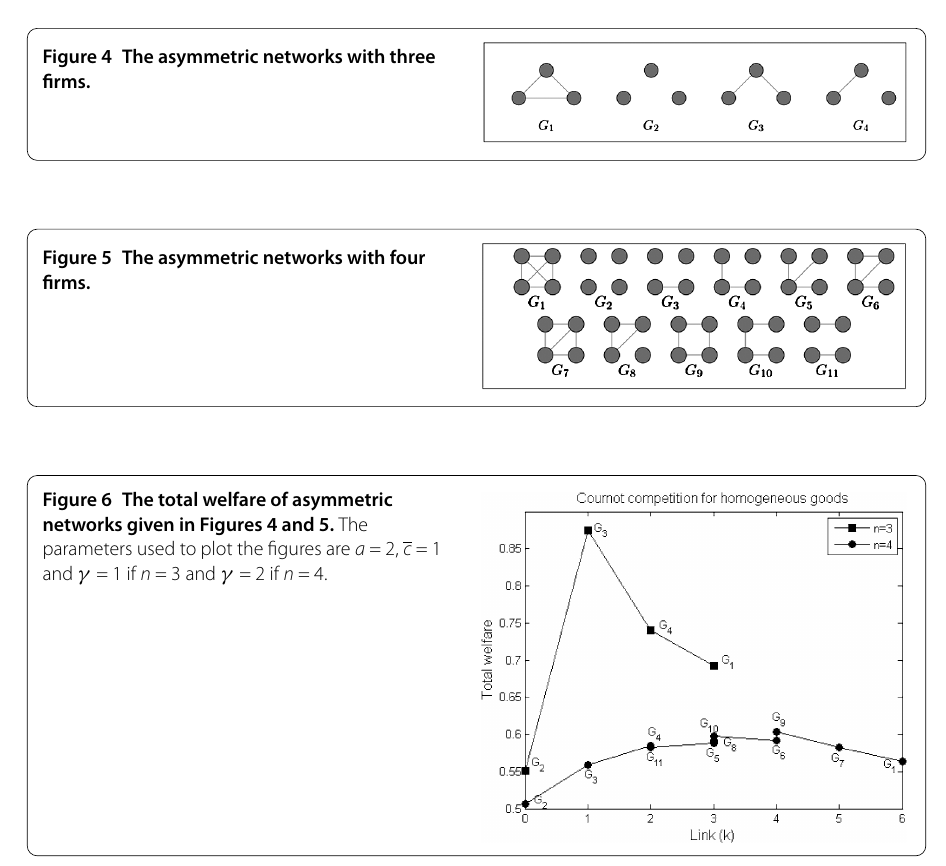
Figure 4 The asymmetric networks with three firms.